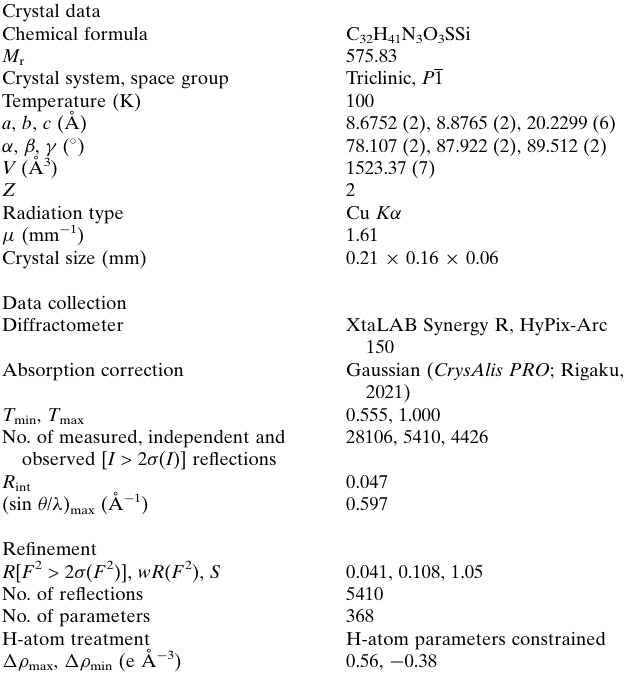
Table 3 Experimental details. Crystal data Chemical